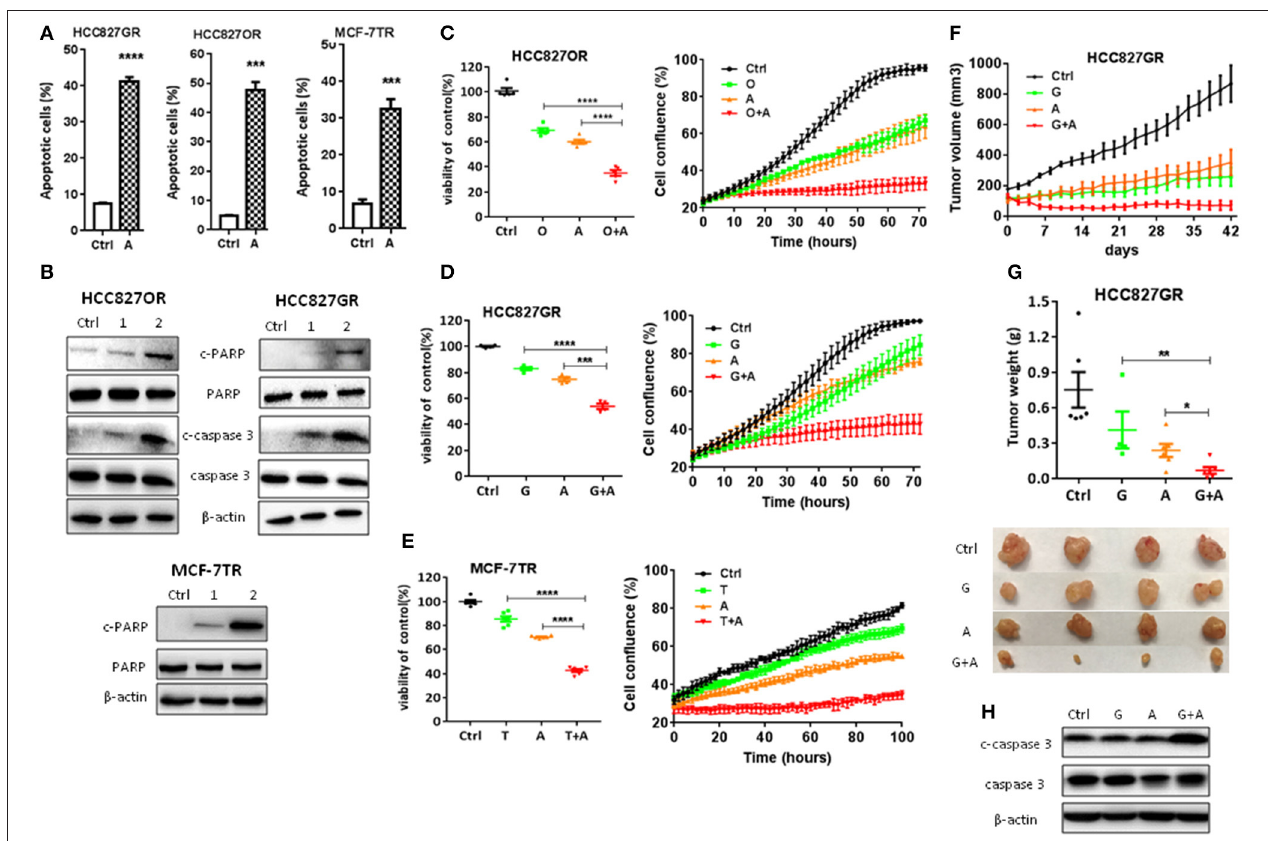
FIGURE 2 | Aspirin overcame acquired resistance to targeted therapy in lung and breast cancers. (A) Quantitative analysis of apoptotic cells in the indicated cells treated with 1mM aspirin for 72h identified by flow cytometry. Data were obtained from three independent experiments. (B) Western blot analysis of c-caspase 3, caspase 3, c-PARP, and PARP in HCC827OR, HCC827GR, and MCF-7TR cells treated with indicated concentrations (mM) of aspirin for 72h. (C–E) Cell viability by CCK8 assay (left panels) and IncuCyte growth curves (right panels) of indicated cells treated with 10 µ M osimertinib (O), 10 µ M gefitinib (G), 1mM aspirin (A), 8 µ M tamoxifen (T), O + A, G + A, or T + A for 72h as indicated. (F–H) HCC827GR-derived xenograft tumors were treated with PBS, 12.5 mg/kg/day gefitinib (G), 100 mg/kg/day aspirin (A), or G + A. The growth curve (F) , and the weight and photographs of tumors (G) . (H) Western blot analysis of c-caspase 3 and caspase 3. β -actin was used as loading control. The data are presented as the means ± SEM. Student’s t -test was used. * P < 0.05; ** P < 0.01; *** P < 0.001; **** P <